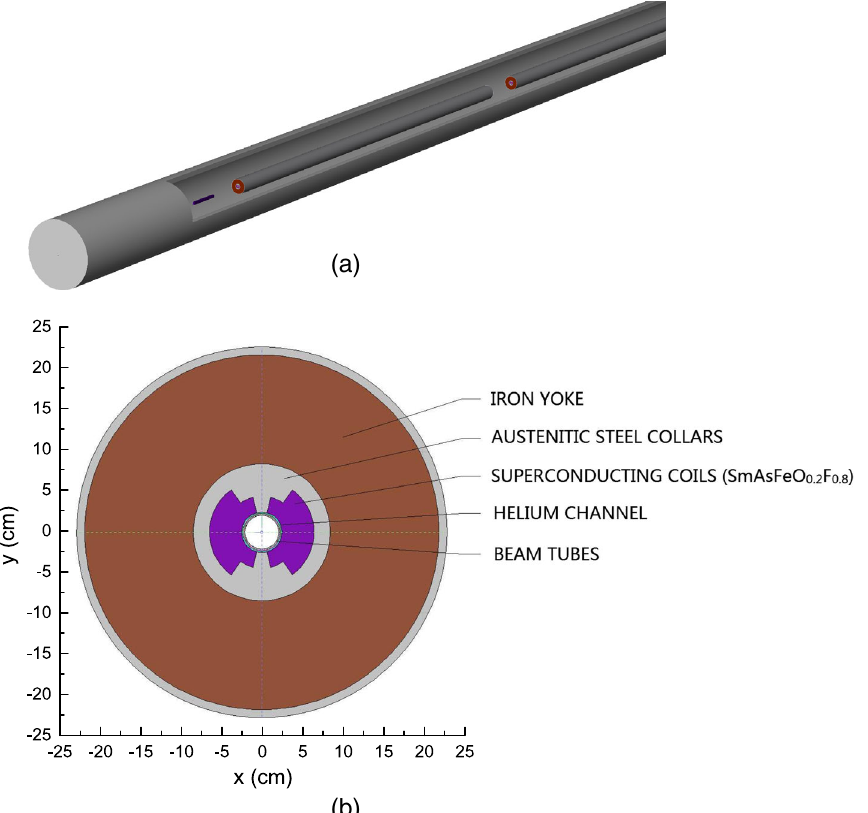
FIG. 16. A 3D geometry model in FLUKA including the first protective collimator and two following SC dipoles B1-4 and B1-5 (a) and the cross section of the SC dipoles in the momentum collimation section (b), where the magnetic fields are not included.